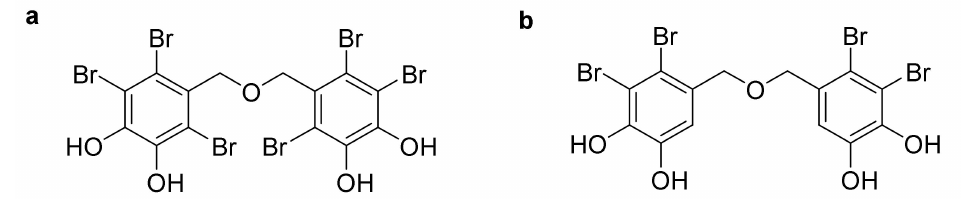
Figure 1. The chemical structure of natural bromophenol bis(2,3,6-tribromo-4,5-dihydroxybenzyl) ether (BTDE, a ) and bis(2,3-dibromo-4,5-dihydroxybenzyl)ether (BDDE, b